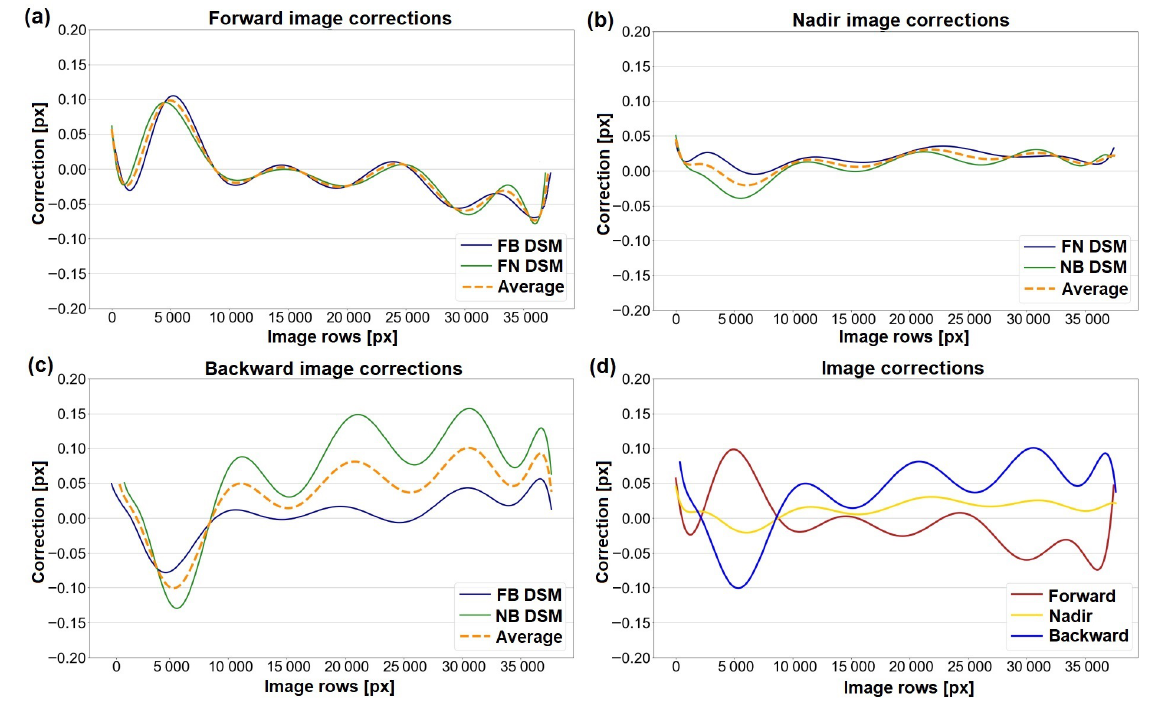
Figure 15. Correction functions for Pléiades satellite imagery: ( a ) Forward image. ( b ) Nadir image. ( c ) Backward image. ( d ) Averaged values.